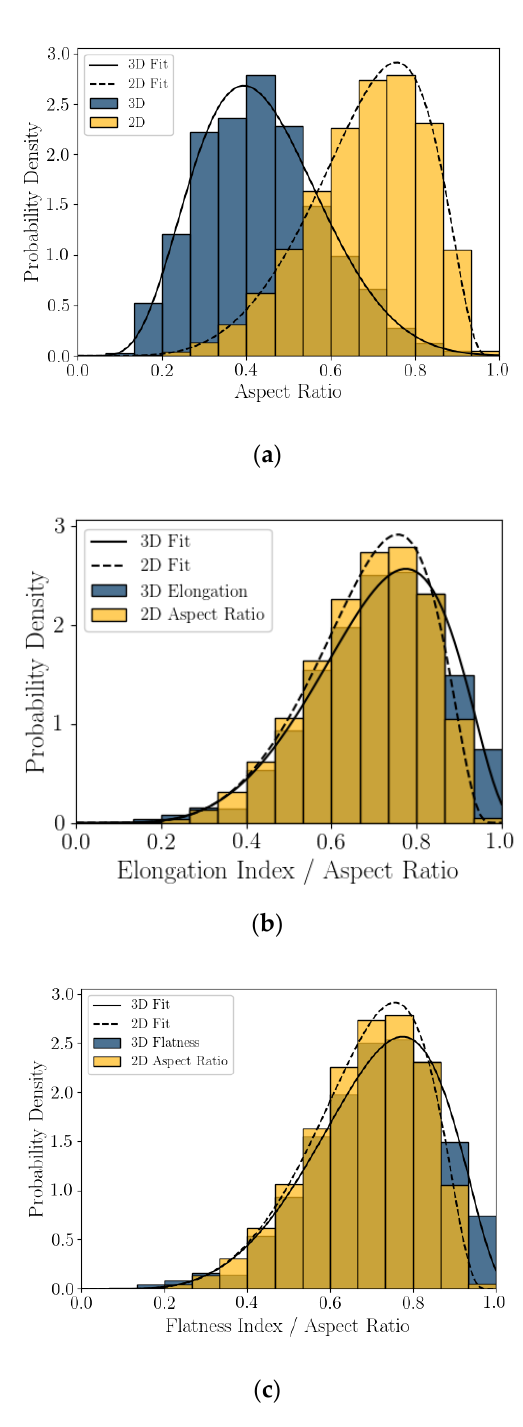
Figure 6. Three shape parameters derived from Feret dimensions: aspect ratio ( a ), elongation index ( b ), and flatness index ( c ), with Johnson Bounded Distribution fitting.